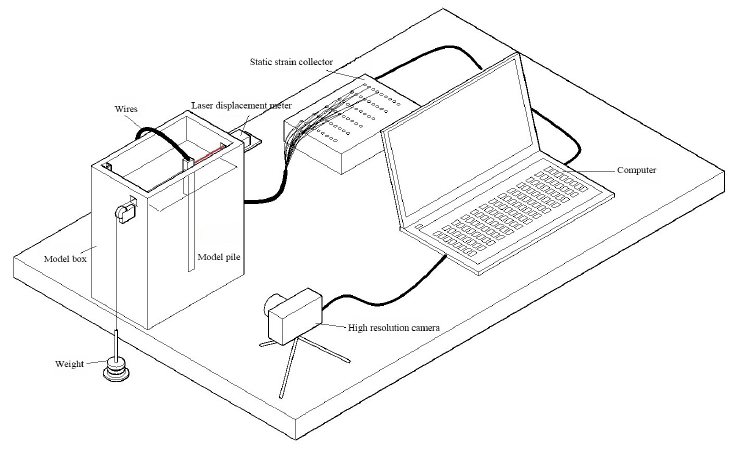
Figure 4. Overall model test device.